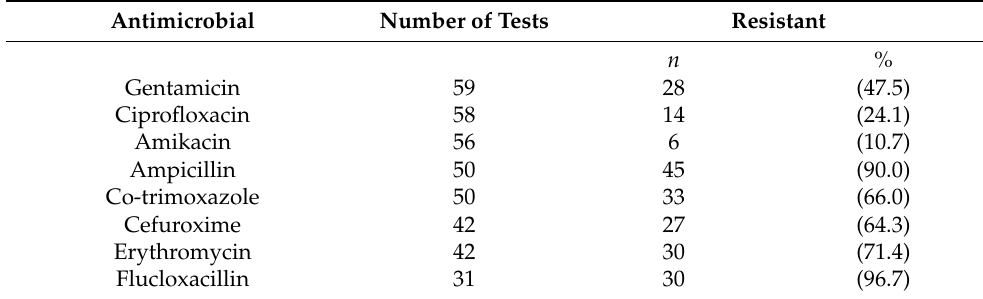
Table 9. Overall status of resistance of isolates to antimicrobials among neonates admitted with